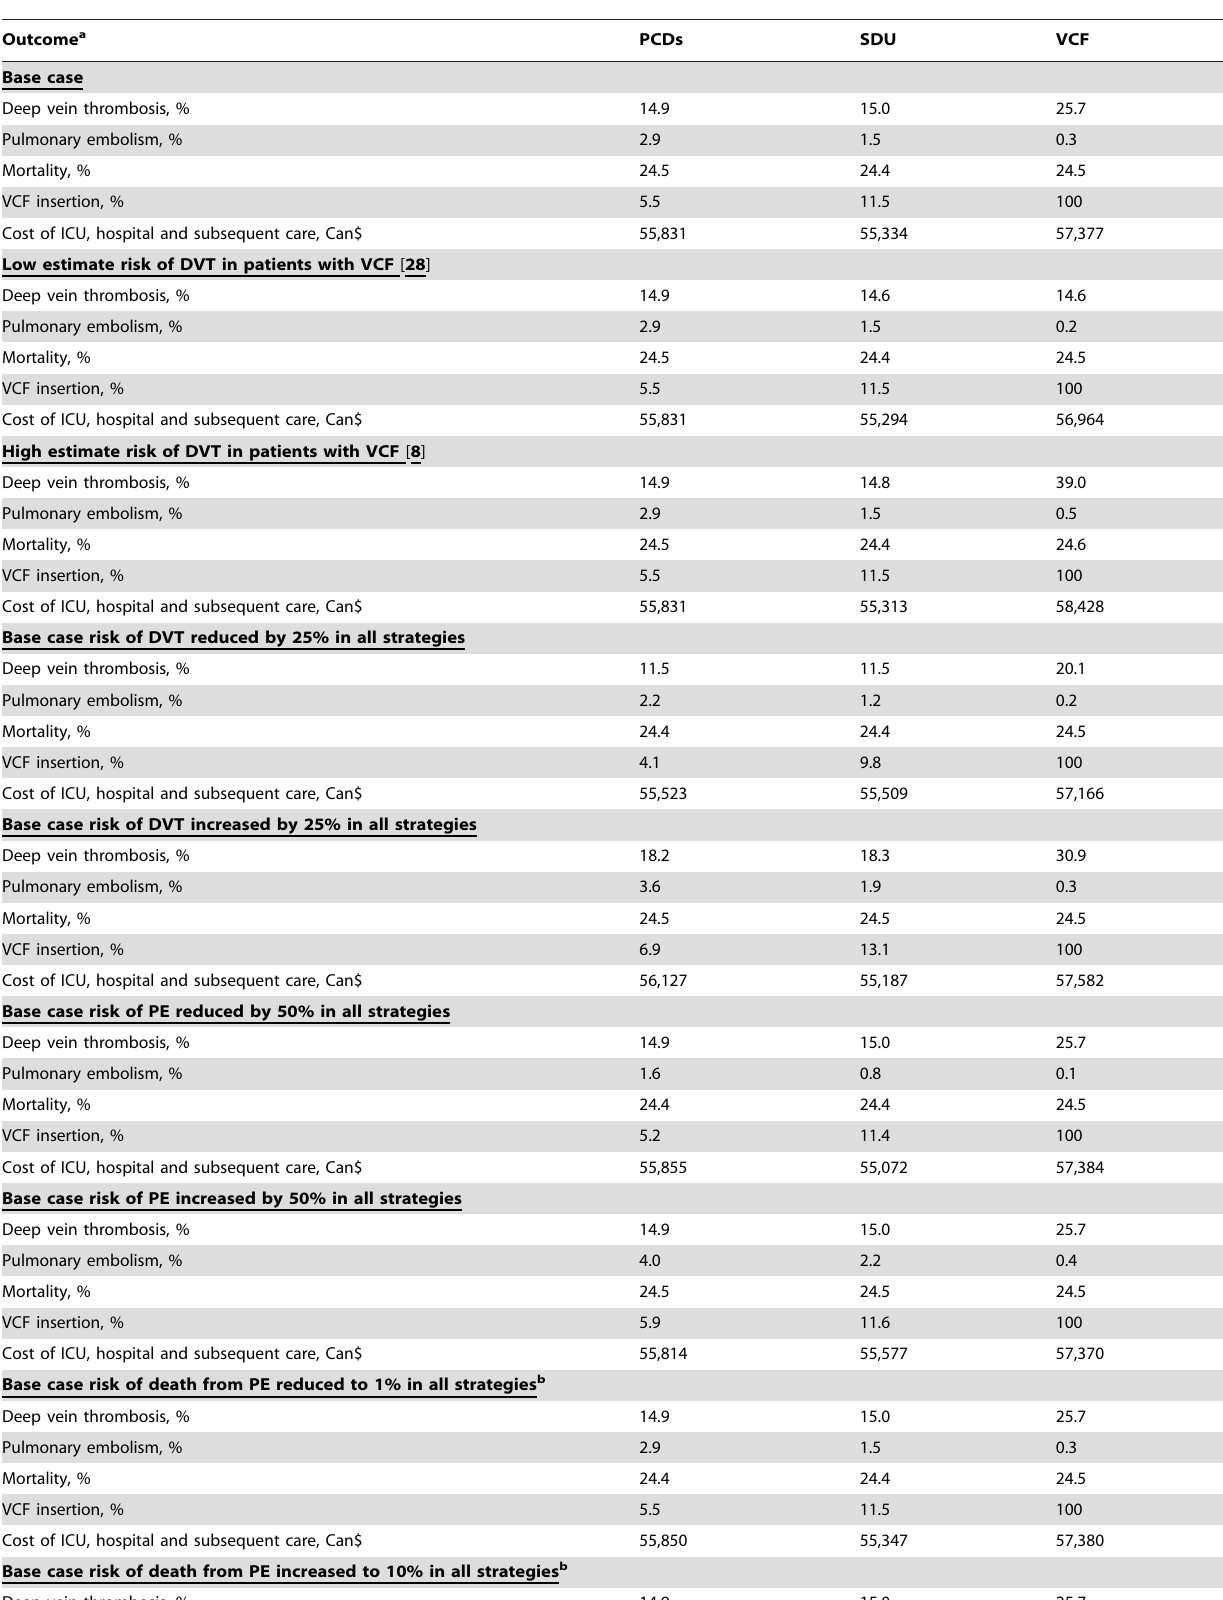
Table 5. Sensitivity analysis of venous thromboembolism prophylaxis strategies.